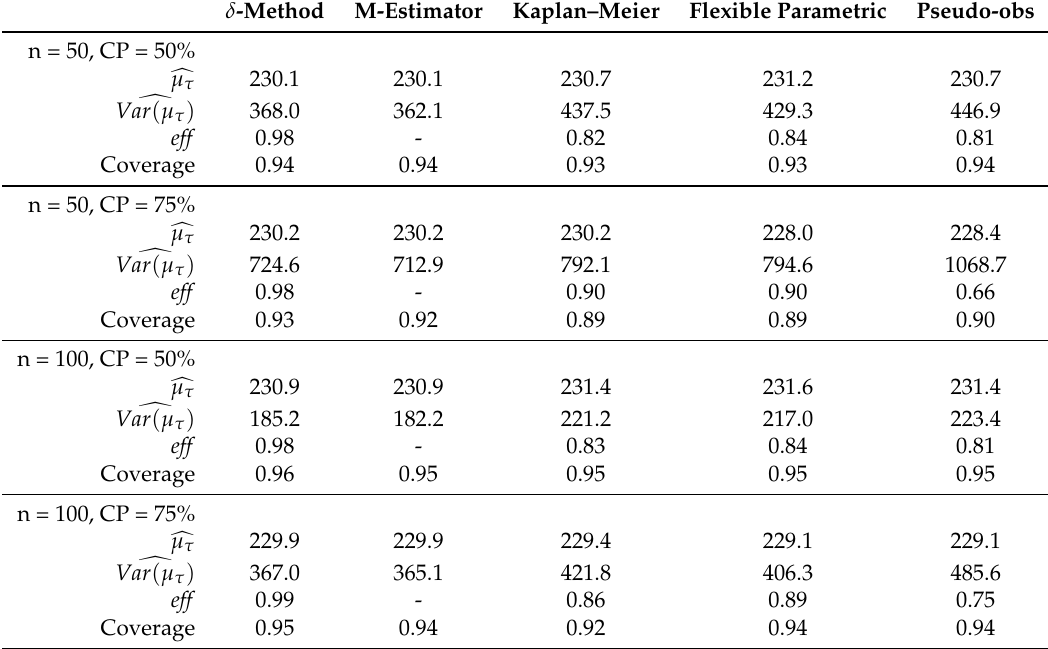
Table 1. Efficacy ( eff ) and 95% confidence interval coverage probabilities of the different Restricted at restriction time of 365 days, with the expected µ τ of 230